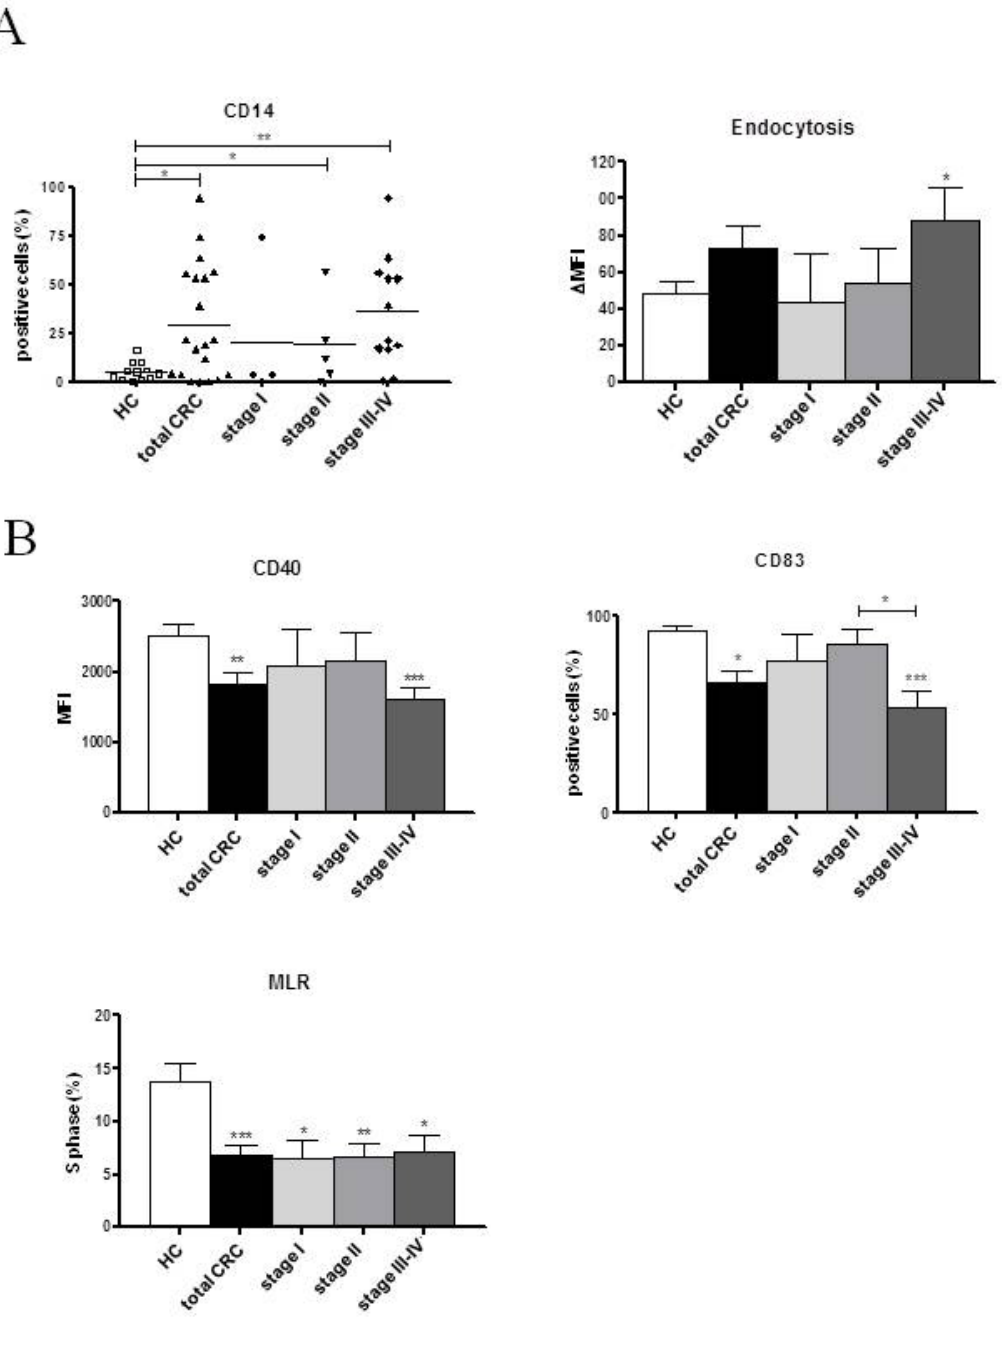
Figure 1. Phenotypic and functional characteristics of MoDCs derived from CRC patients at the pre-surgery timepoint. Evaluations were performed at the ( A ) sixth and ( B , C ) seventh days (after LPS addition) of culture. CRC patients, n = 23; stage I, n = 5; stage II, n = 6; stage III-IV, n = 12; HCs n = 14. Data are shown as the means ± SEM. * p < 0.05; ** p < 0.01; *** p < 0.001. Statistical significance is in comparison to HCs, except where indicated. MoDCs: monocyte-derived dendritic cells; LPS: lipopolysaccharide; HC: healthy controls; CRC: colorectal cancer; MLR: mixed lymphocyte reaction; MFI: mean fluorescence intensity. The n indicates the number of cases